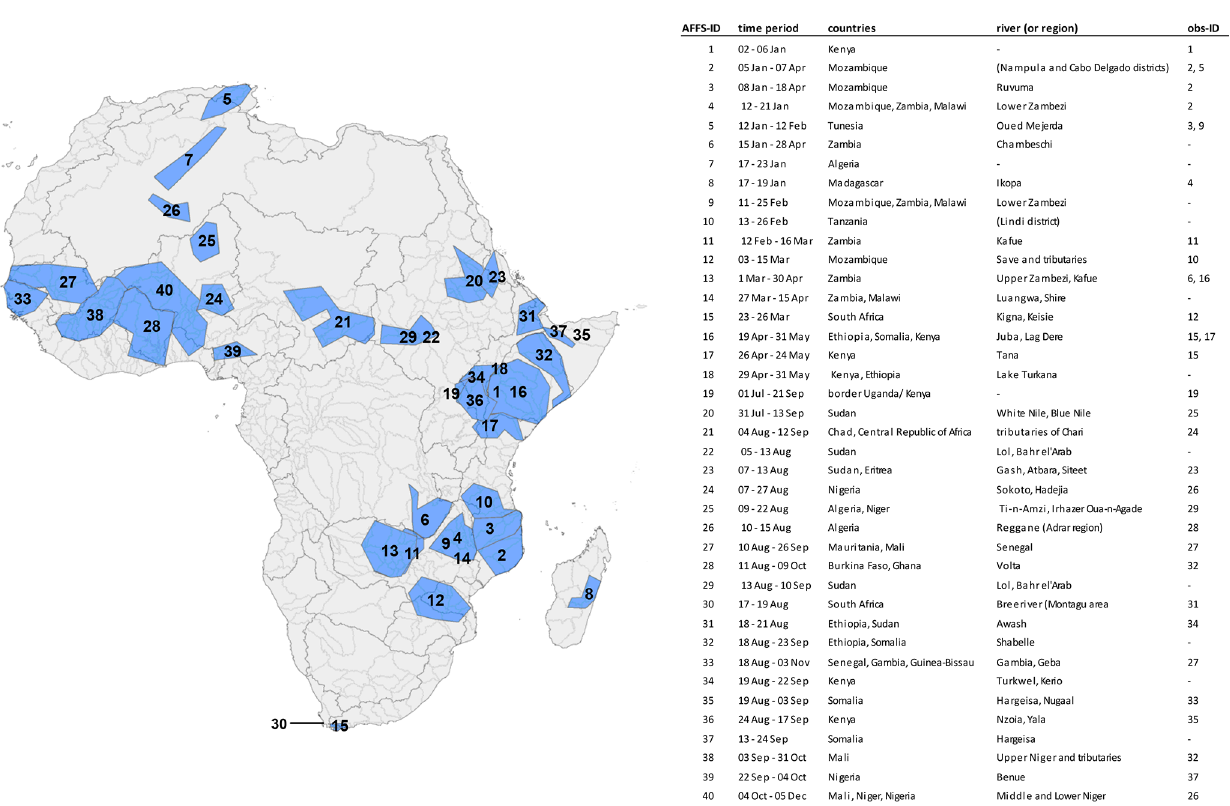
Figure 4. Flood events in Africa, in 2003, as forecasted by AFFS. The map on the left indicates the outline of the affected regions, while the table on the right gives further details on time period and